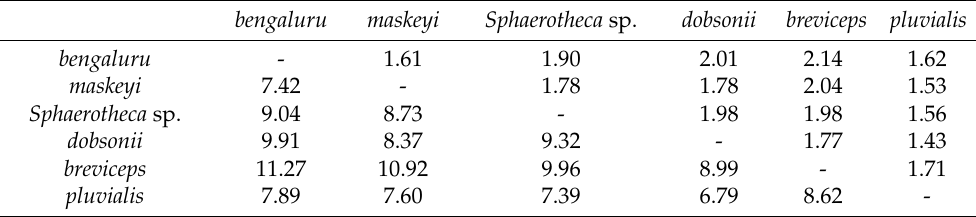
Table 1. Uncorrected genetic distances (%) between investigated Sphaerotheca sequences as shown in Figure 1. Given are p-distance values for 16S mitochondrial gene (lower-left) and standard error estimates (upper-right). The complete pairwise p-distance matrix is presented in Supplementary Table S2. bengaluru maskeyi Sphaerotheca sp. dobsonii breviceps pluvialis